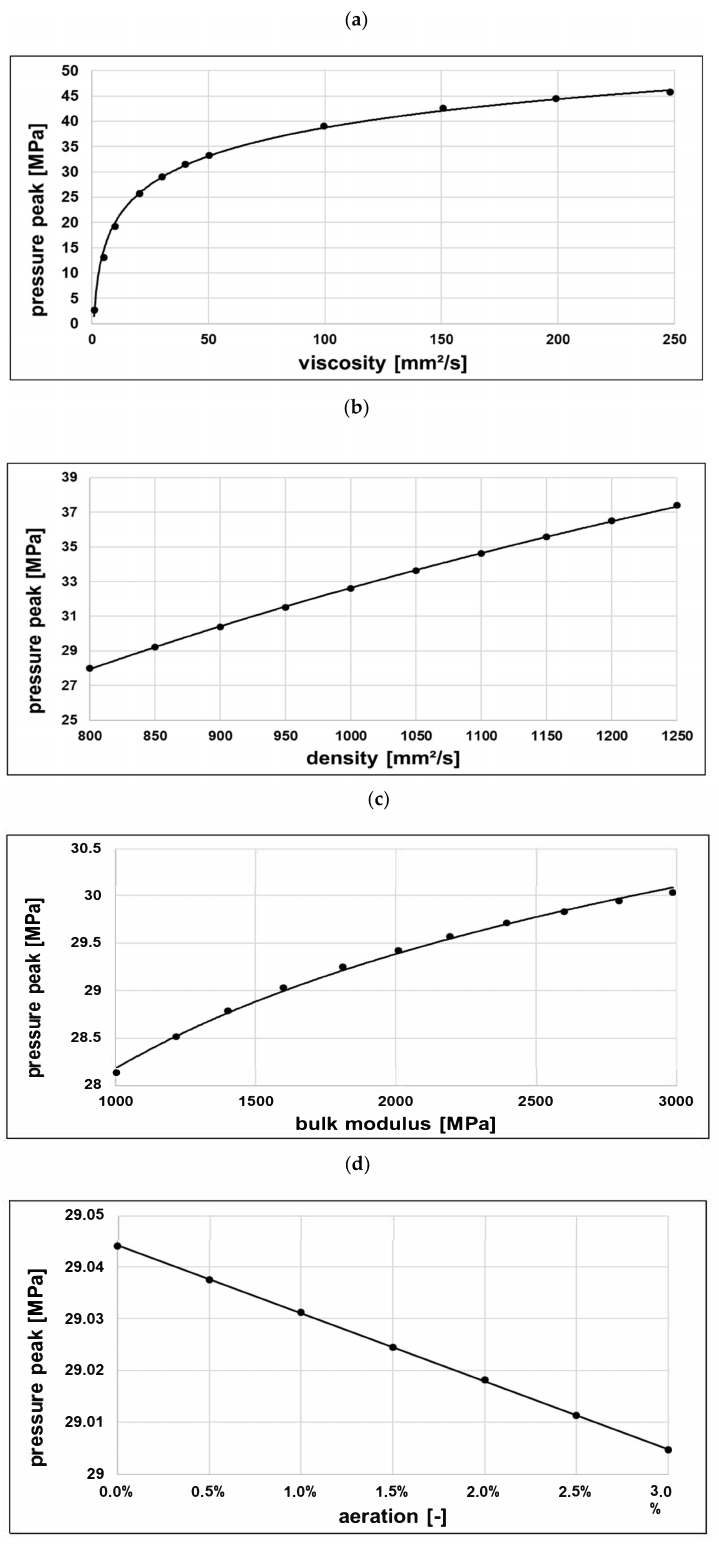
Figure 26. Influence of the properties of hydraulic fluid on the pressure peaks value: ( a ) influence of viscosity; ( b ) influence of density; ( c ) influence of the bulk modulus; ( d ) influence of aeration. All simulations were conducted with the following settings: pumping pressure p_o = 10 MPa, rotational speed n = 1500 rpm, and displacement setting x = 20%. All constant fluid parameters were properties of the Total Azolla 46 oil, calculated at a temperature of 50 ◦ C and at 0%